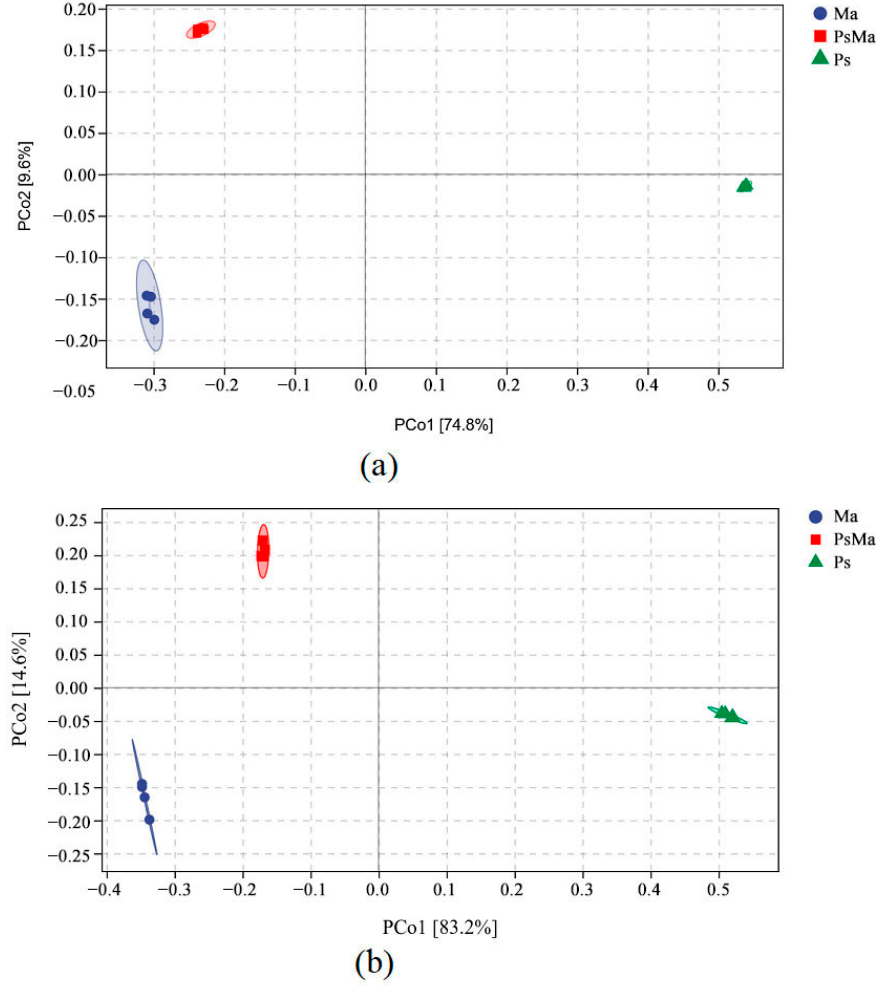
Figure 3. Principle coordinate analysis (PCoA) of Bray–Curtis’s distance from all samples. ( a ): PCoA of bacterial communities in different samples; ( b ): PCoA of fungal communities in different samples. Ma: Morus alba ; PsMa: Pinus sylvestris var. mongolica × Morus alba ; Ps: Pinus sylvestris var. mongolica